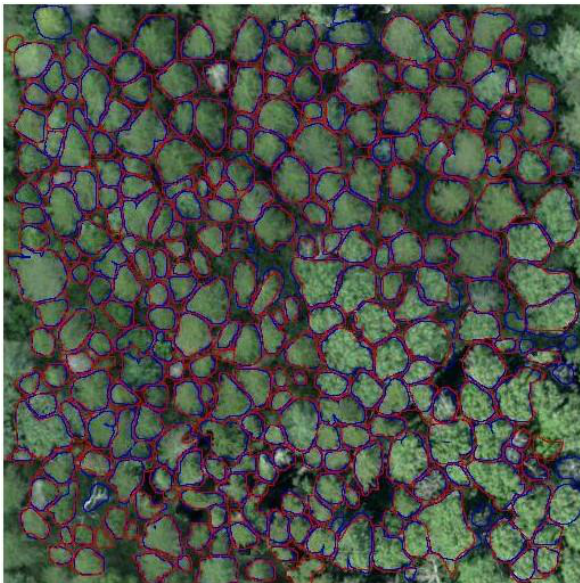
Figure 5 . ITC delineation result (blue circle) generated by U-net, together with the tree crowns manually labelled (red circles) for the test size #1.